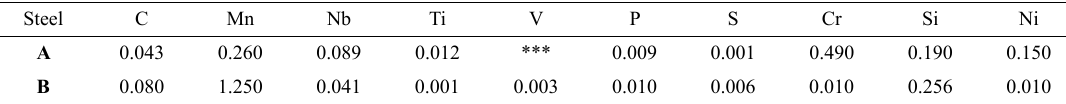
Table 1. Chemical composition of the studied steels